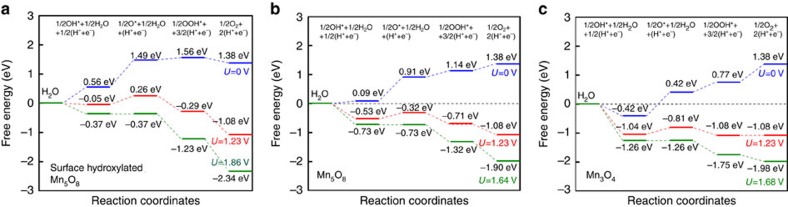
DFT calculations.The free energy evolution for water splitting steps at different potentials on surfaces of (a) surface hydroxylated Mn5O8, (b) pure Mn5O8 and (c) Mn3O4 predicted from DFT.